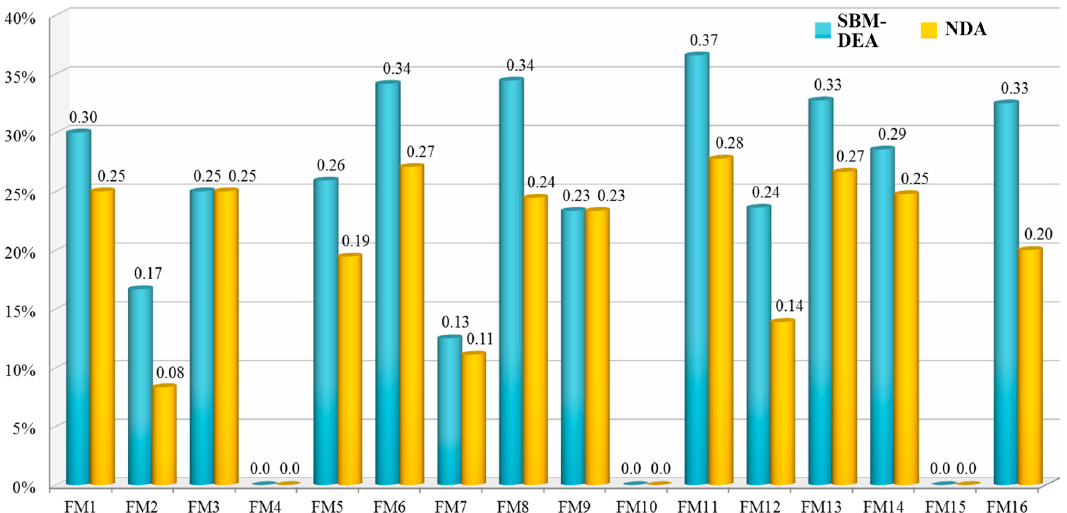
Figure 3. The average reduction rates between SBM and our approach.